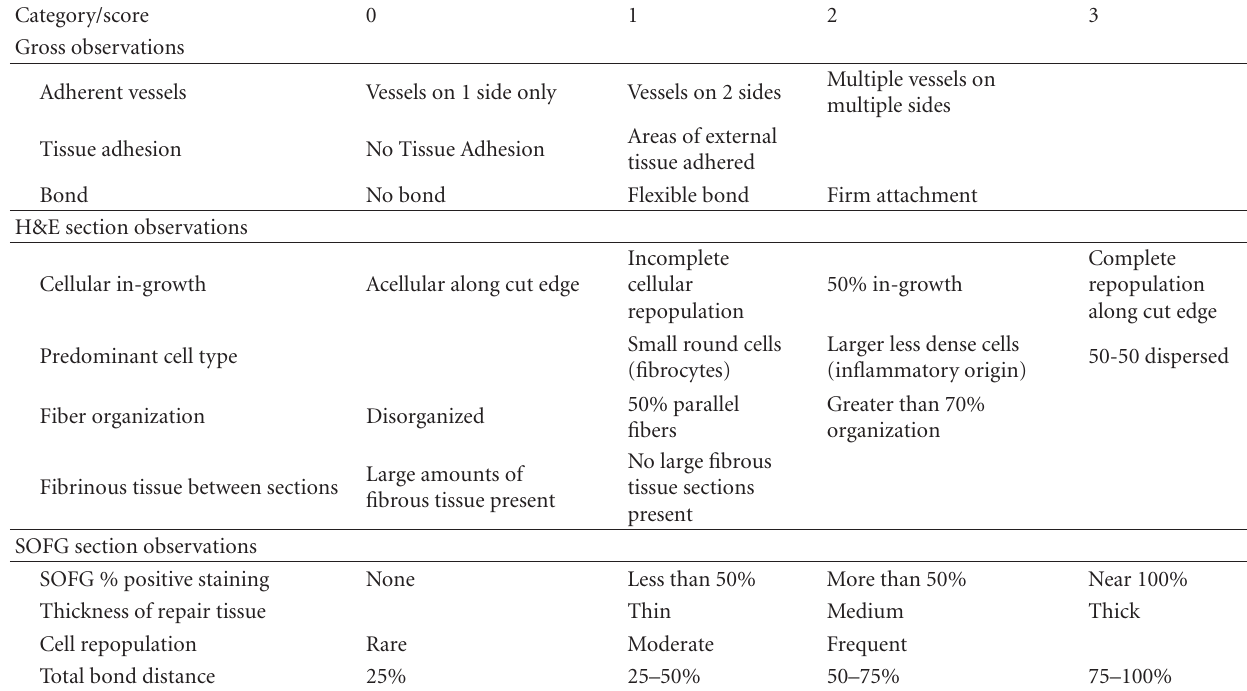
Table 1: Explanation of grading rubric used in the current study and the coding used for the